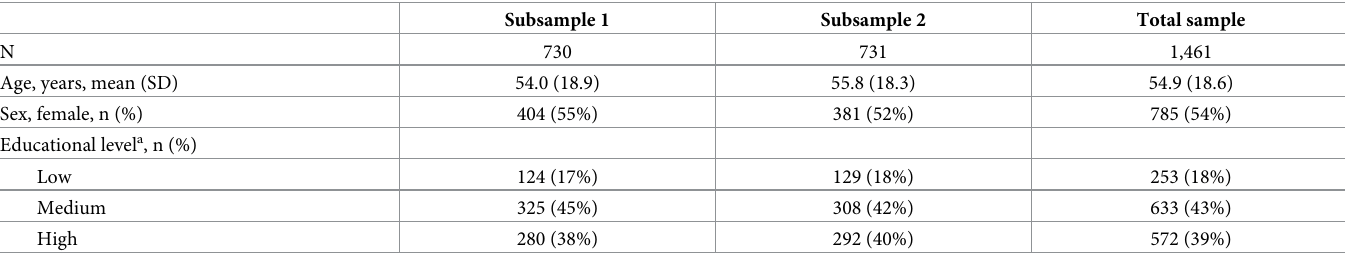
Table 1. Characteristics of